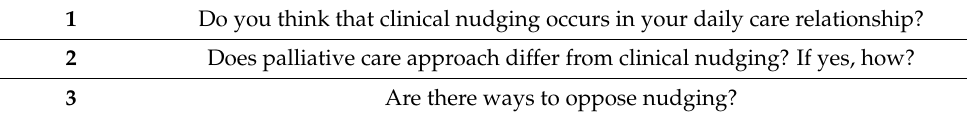
Table 1. The FG guiding